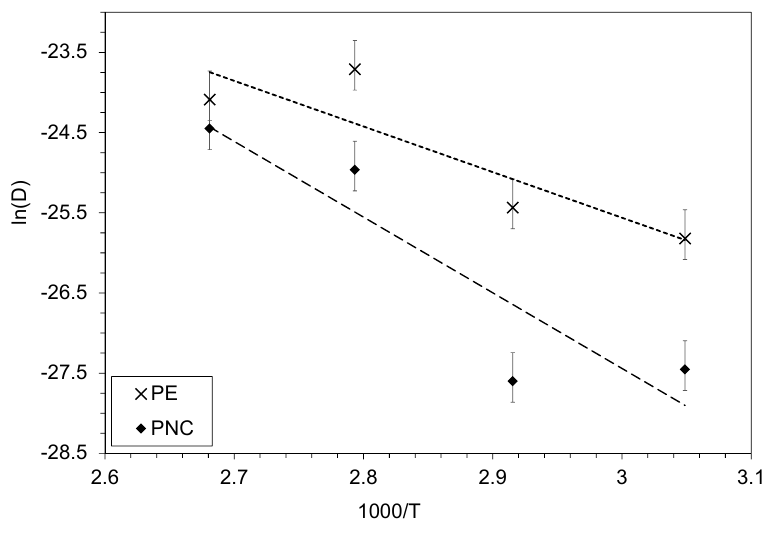
Figure 5. Arrhenius plot for biphenyl in PE and PNC. Crosses and diamonds stand for experimental data with the associated error bars while the dash lines represent the modeled curves obtained from the